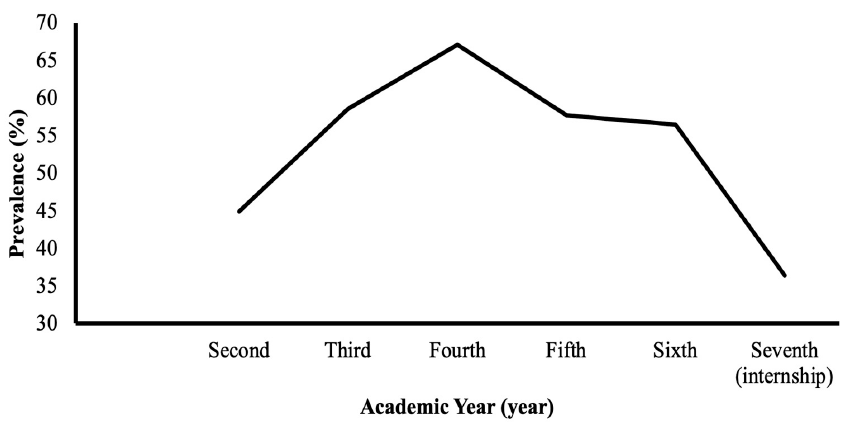
Figure 1. Prevalence of burnout per academic year in medical school among study participants. Participants were classified as burned-out and not burned-out according to a cut-off score of 9. Table 1. Categorization of burnout according to selected students’ characteristics.